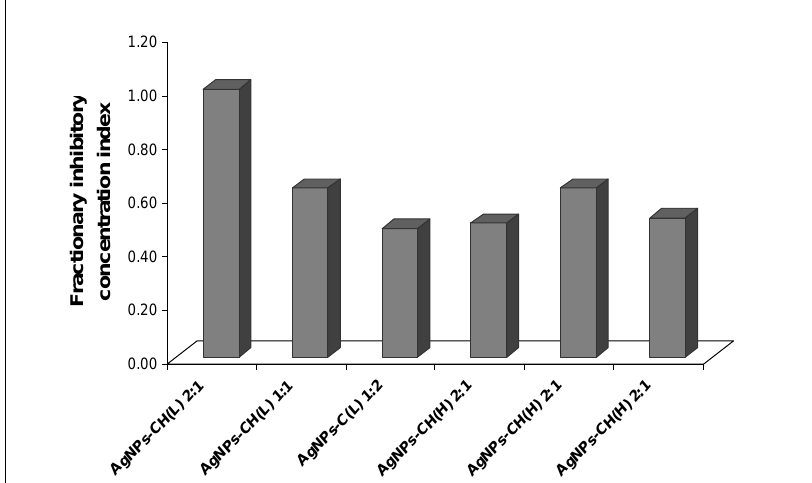
Figure 7. The variation of the fractional inhibitory concentration index of AgNP–chitosan solution mixtures measured for the inhibition of E. coli growth; CH(L) – low molecular weight chitosan; CH(H)—high molecular weight chitosan.